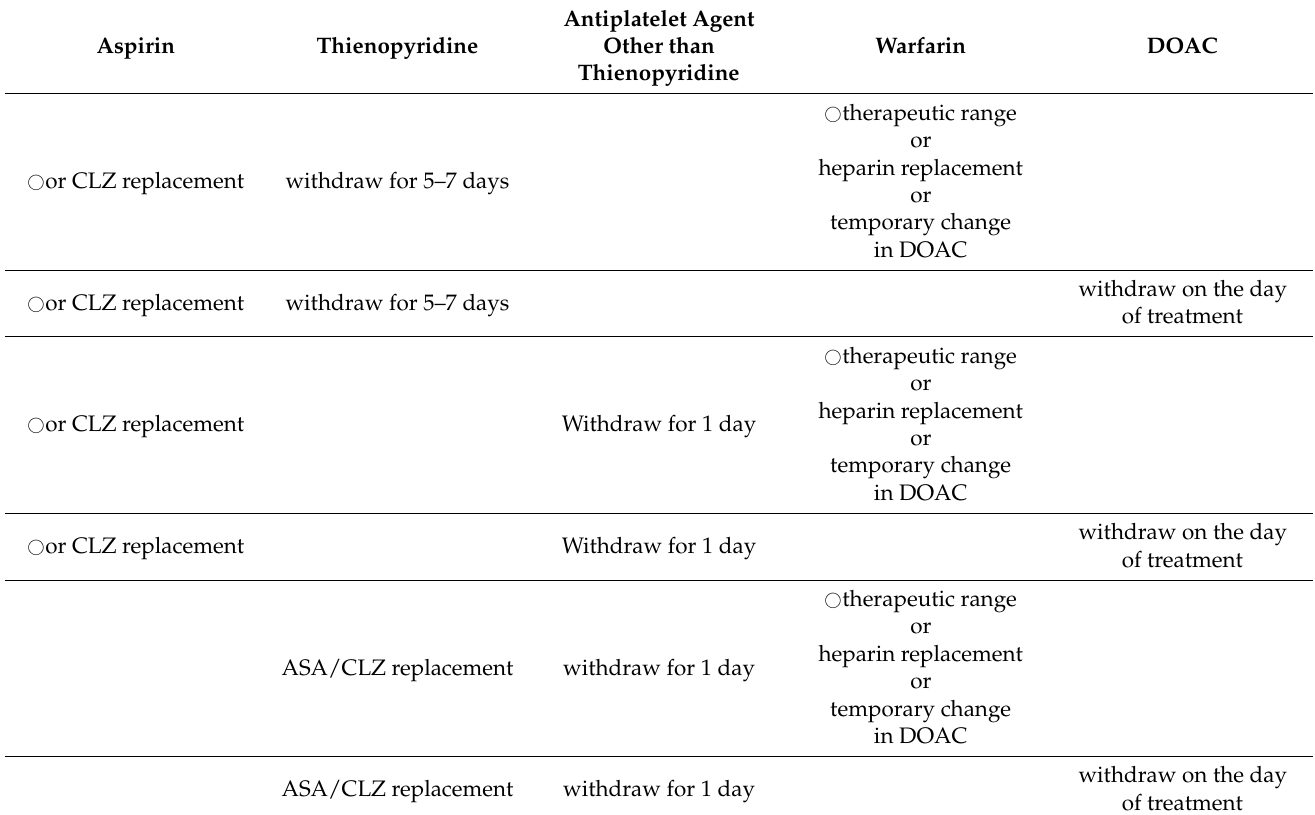
Table 3. Withdrawal of triple therapy with antiplatelet agents or anticoagulants during gastroenterological endoscopy. Aspirin Thienopyridine